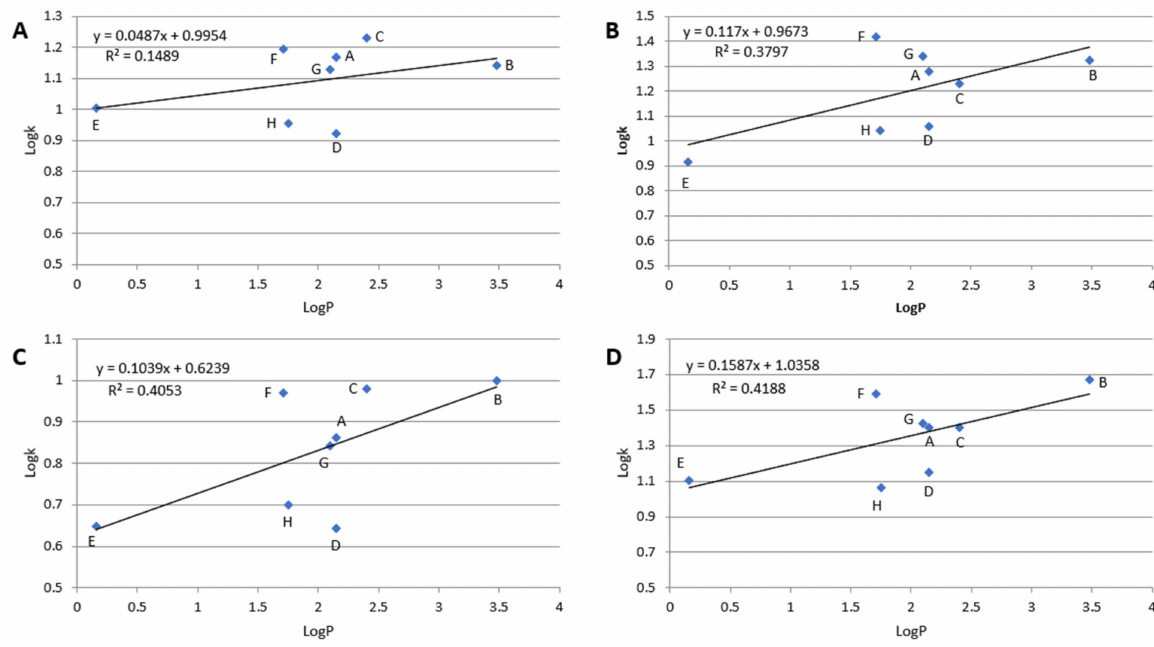
Figure 4. Dependences of log k vs. log P; ( A )–Diol-P-Benzyl, ( B )–Diol-P-C18, ( C )–Diol-P-C10, and ( D )–Diol-P-Chol measured for 10% ACN in 10 mM ammonium acetate in water. (A)–metoprolol, (B)–propranolol, (C)–ciciloprolol, (D)–mexiletine, (E)–atenolol, (F)–acebutolol, (G)–oxprenolol, and